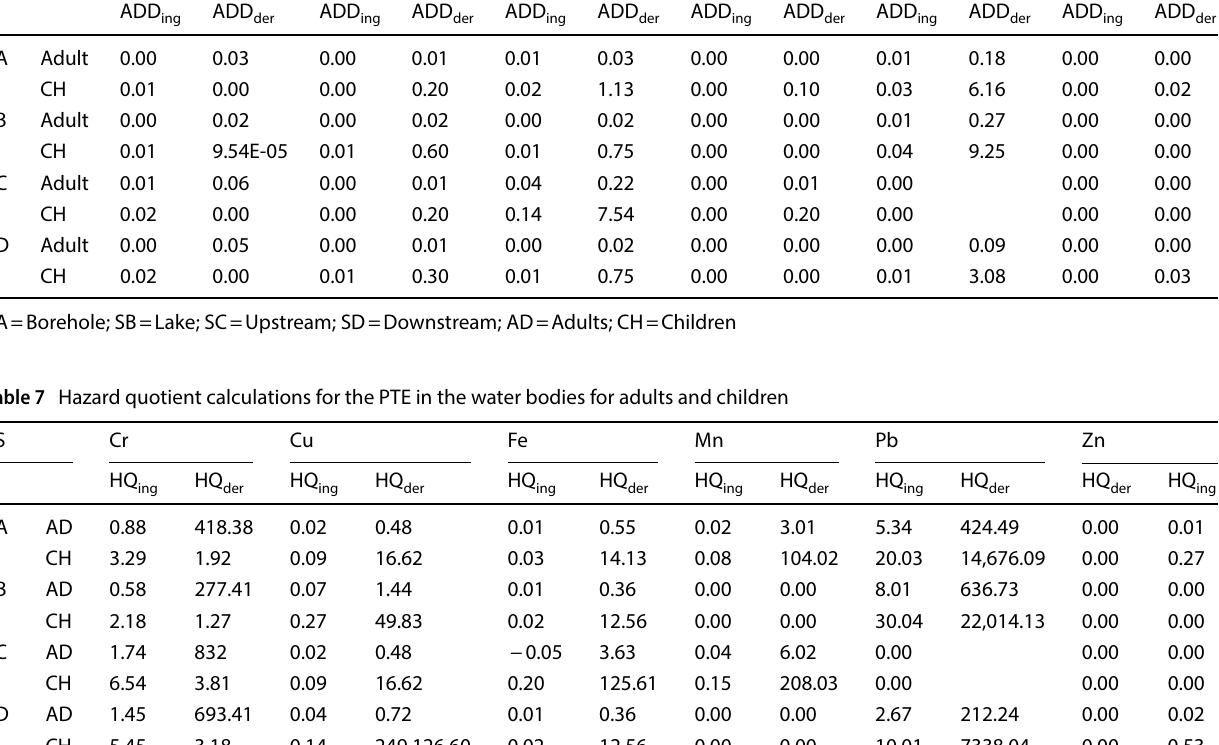
hazard quotient via igestion; HQ ing der